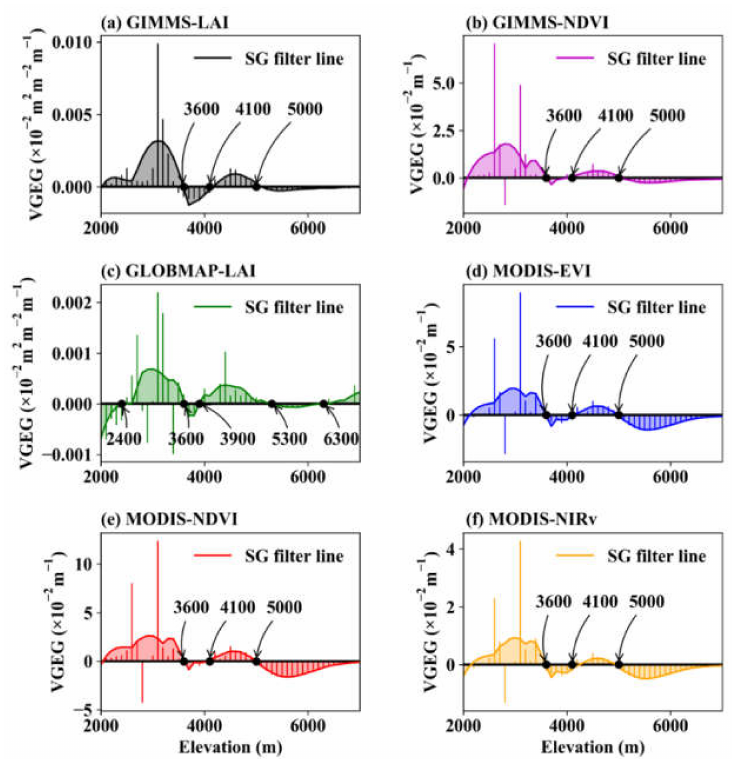
Figure A2. VGEG distributed in elevational gradients. The black circle denotes the turning elevation, and the solid line denotes the SG filter line.